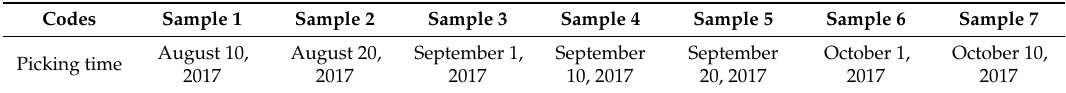
Table 4. Samples of RSM from different stages of